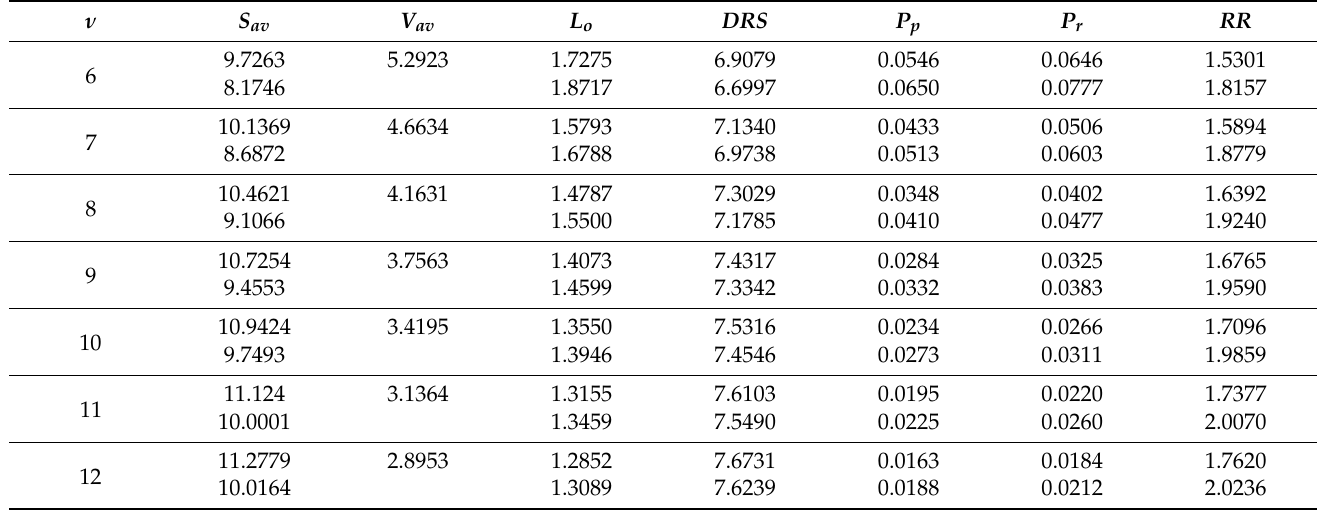
Table 4. Dependence of the performance measures on parameter ν ; λ = 20, η = 15, κ = 8, α = 0.4, and β = γ = 0.6.